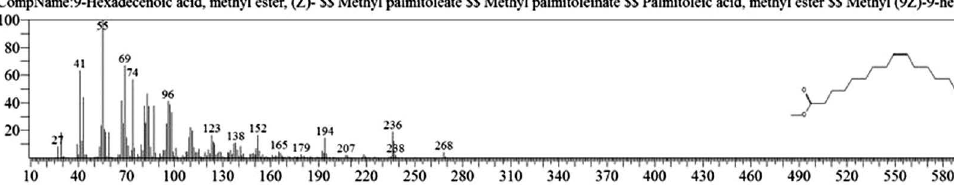
Fig. 15. Oleic acid